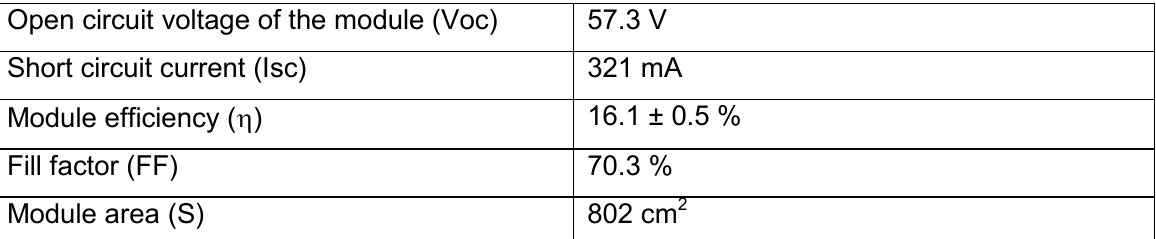
Table 1. Manufacturing characteristics of the module